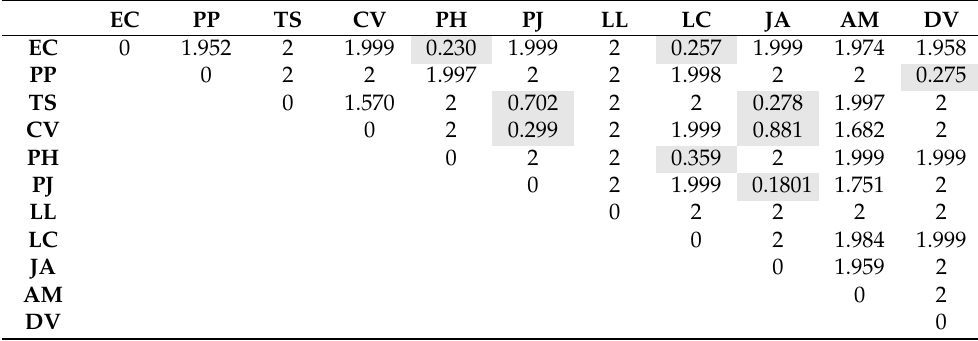
Table 8. The JM distance between 11 plant species using two bands (724 and 725 nm). The species pairs having a separability level below the threshold (JM index of 1.90) are